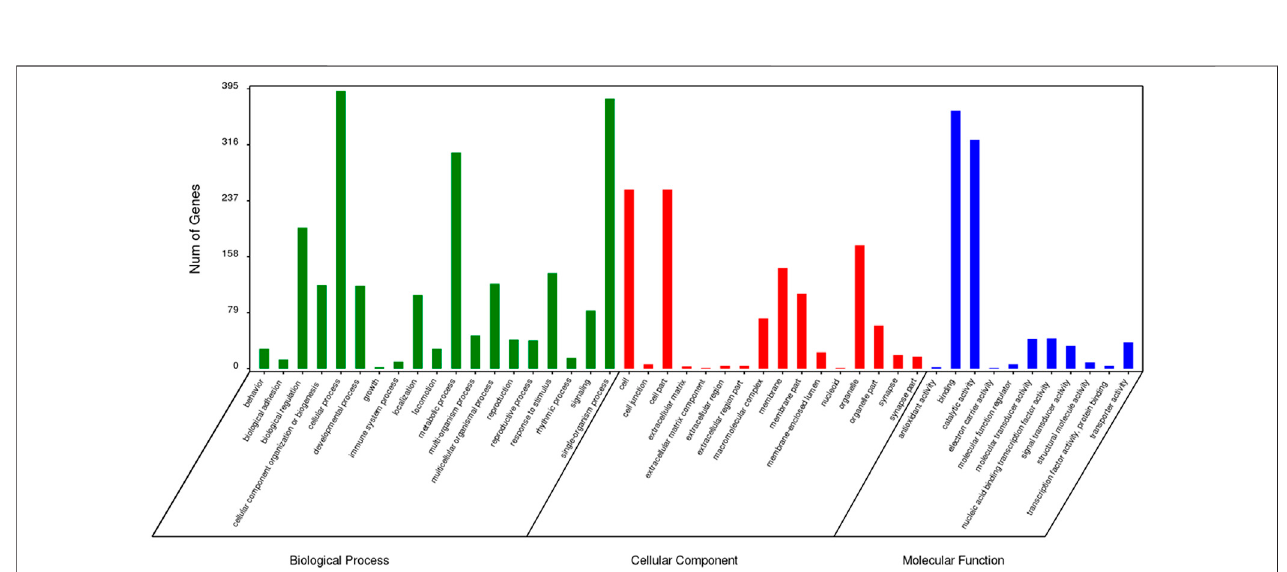
FIGURE 7 | GO function classi fi cation of speci fi c genes of Ceratitis capitata (Wiedemann).